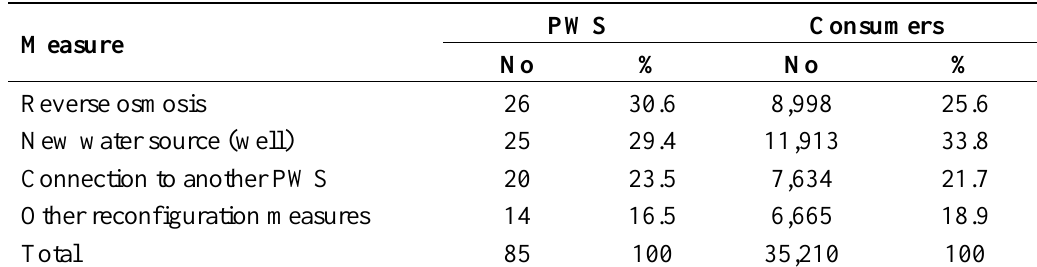
Table 2. Measures implemented to reduce fluoride content in drinking water during 2004–2012 in